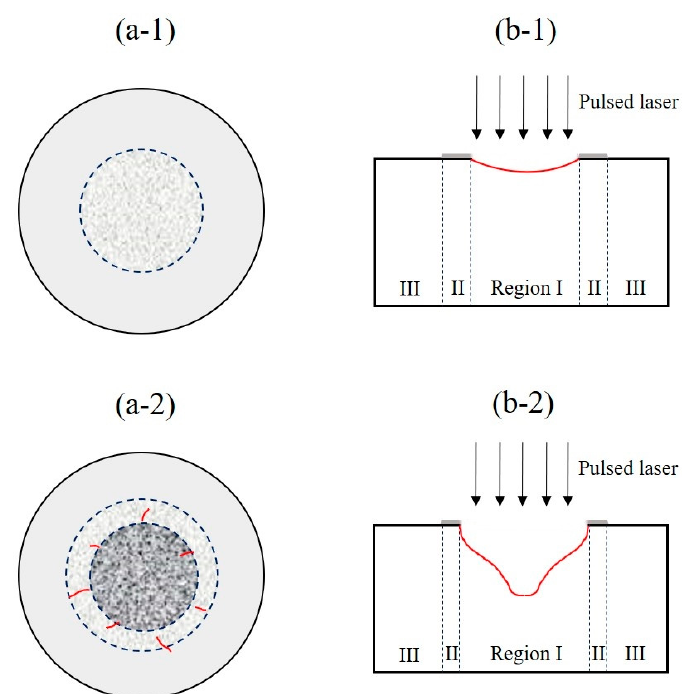
Figure 7. Laser ablation model of the C / SiC composite. The e ff ect of laser power density (single pulse): ( a-1 ) low power density, ( a-2 ) high power density. The e ff ect of pulse number (multiple pulses): ( b-1 ) low power density, ( b-2 ) high power density.